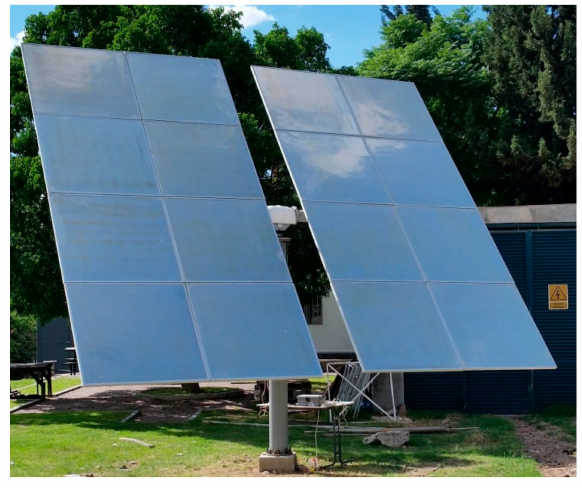
Figure 18. Heliostat.